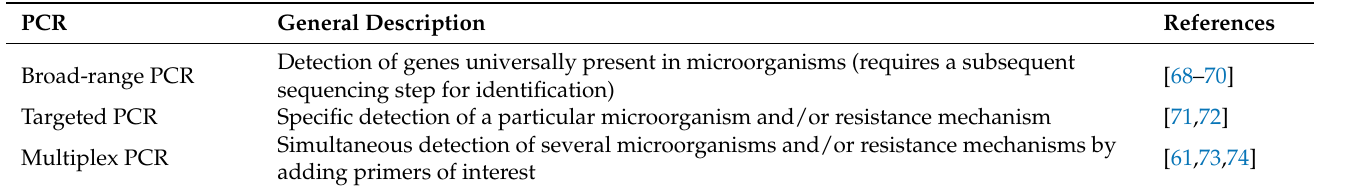
Table 2. Different types of PCR applied to the diagnosis of